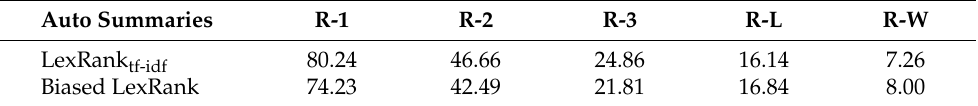
Table 8. ROUGE metrics’ comparison of automatic extractive summarization methods using the human evaluators’ highlights summaries as a reference. We report the average ROUGE F1-score, over all evaluators and all Court judgment summaries, in our human evaluation